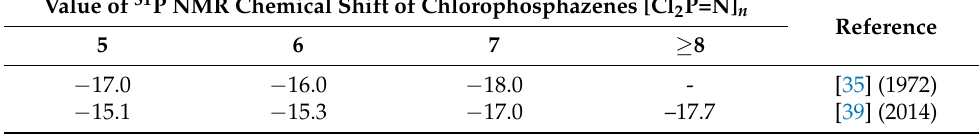
Table 1. 31 P NMR chemical shifts of